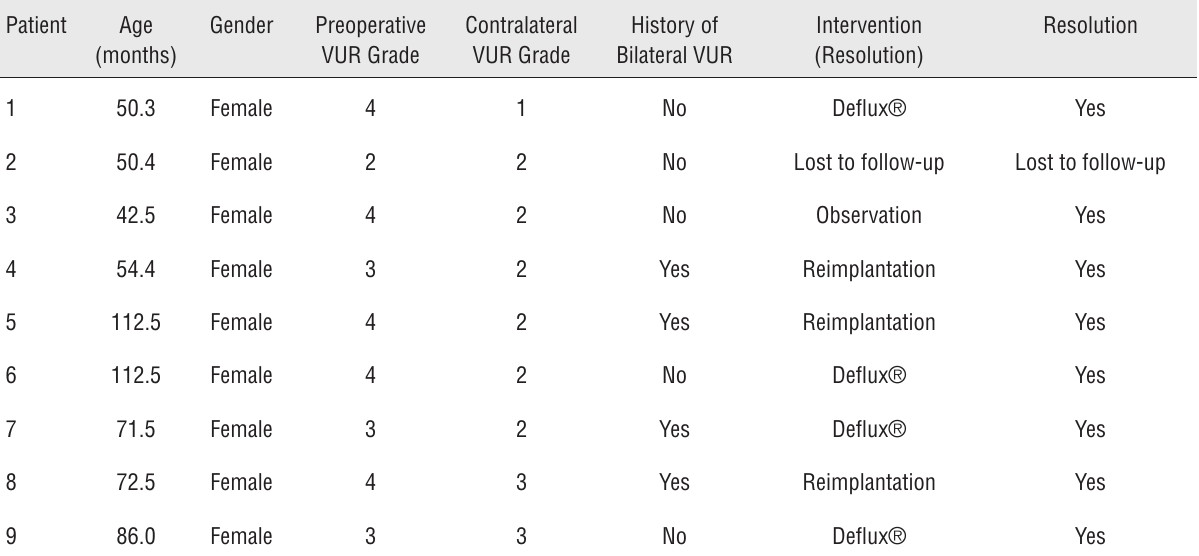
Table 3 - Characteristics of patients with de novo contralateral VUR.